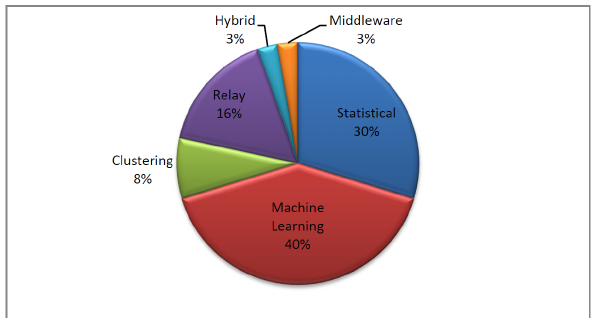
Figure 1. Distribution rates of the used